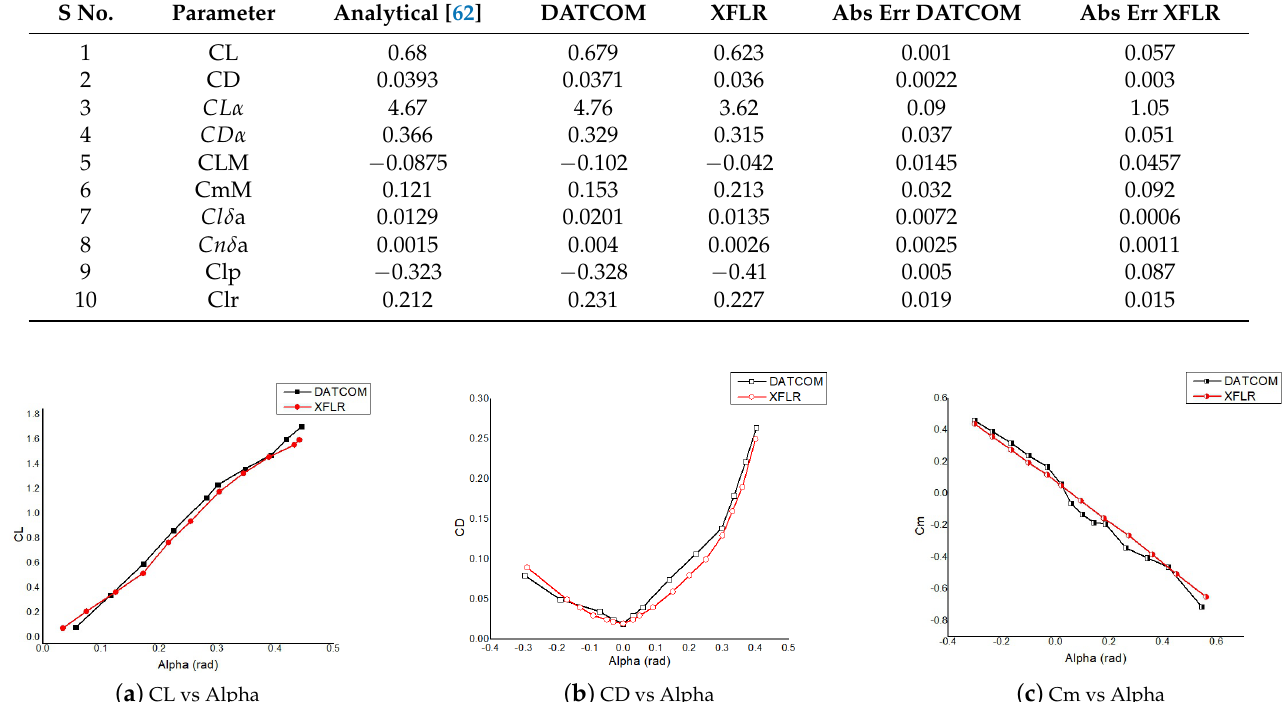
Table 4. Comparison of aerodynamic coefficients obtained from DATCOM and XFLR with analytical results. S No.